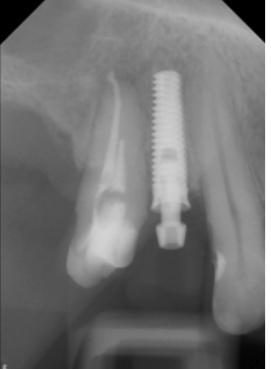
Figure 14. Dental X-ray after dental implantation.